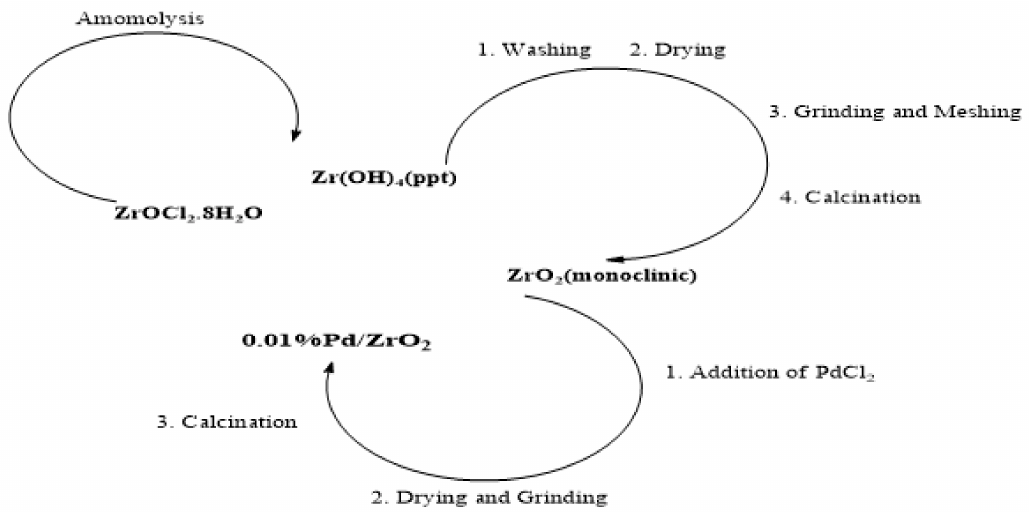
Figure 2. Preparation of catalyst Pd/ZrO 2